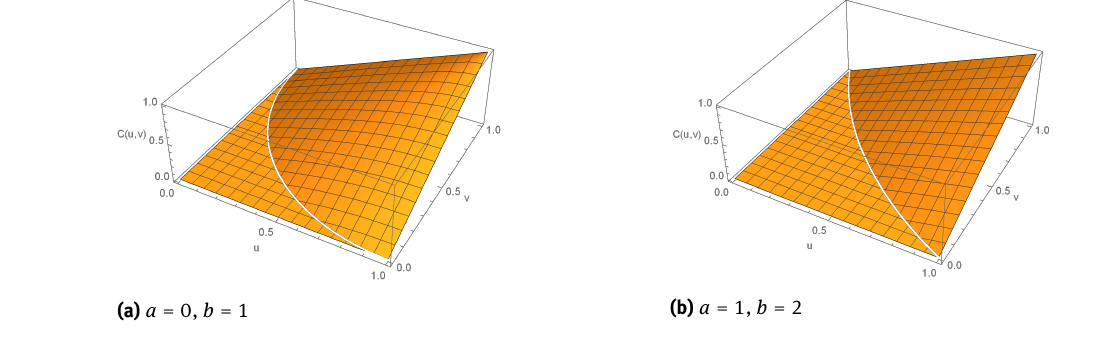
Figure 11: Copula surface for Uniform Lorenz